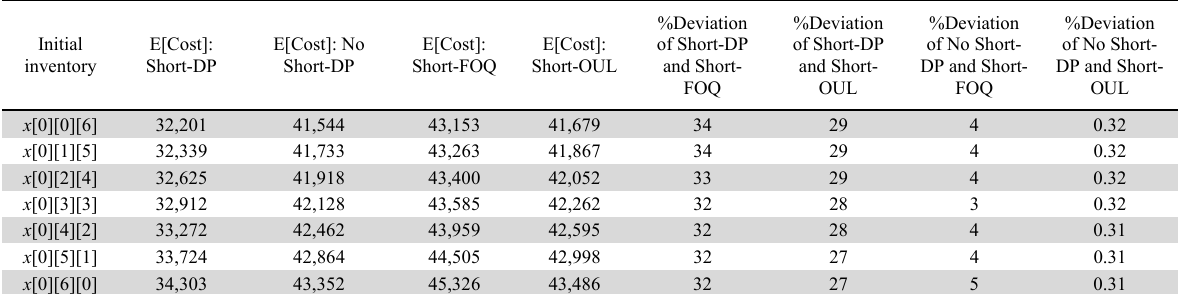
Comparison of the optimal policy (in THB) given the initial stock, short-FOQ, and short-OUL with and without shortage allowance